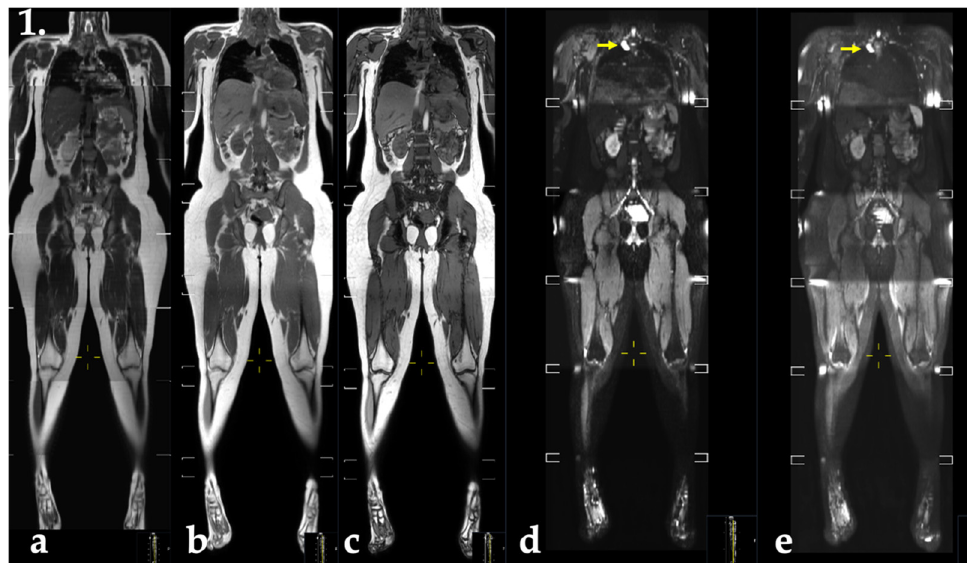
Figure 1. Display protocol of MR-imaging pulse sequences as specified in the SWEP53 study (female). Coronal stitched reformatted whole-body images with ( a ) T2-weighted ( b ) T1-weighted Dixon-based gradient-echo sequence with fat and water. ( c ) Opposed-phase (water and fat images no shown), echo-planar-based diffusion weighted images with b-values of ( d ) 50 s/mm 2 and ( e ) 800 s/mm 2 . A 30 mm paravertebral thoracic lesion was found ( d , e ), yellow arrows, regarded as a schwannoma. Note the incomplete coverage of the distal part of the extremities on the whole-body images, in this case due to the individual’s size. The performed breast and brain MRI are not shown.